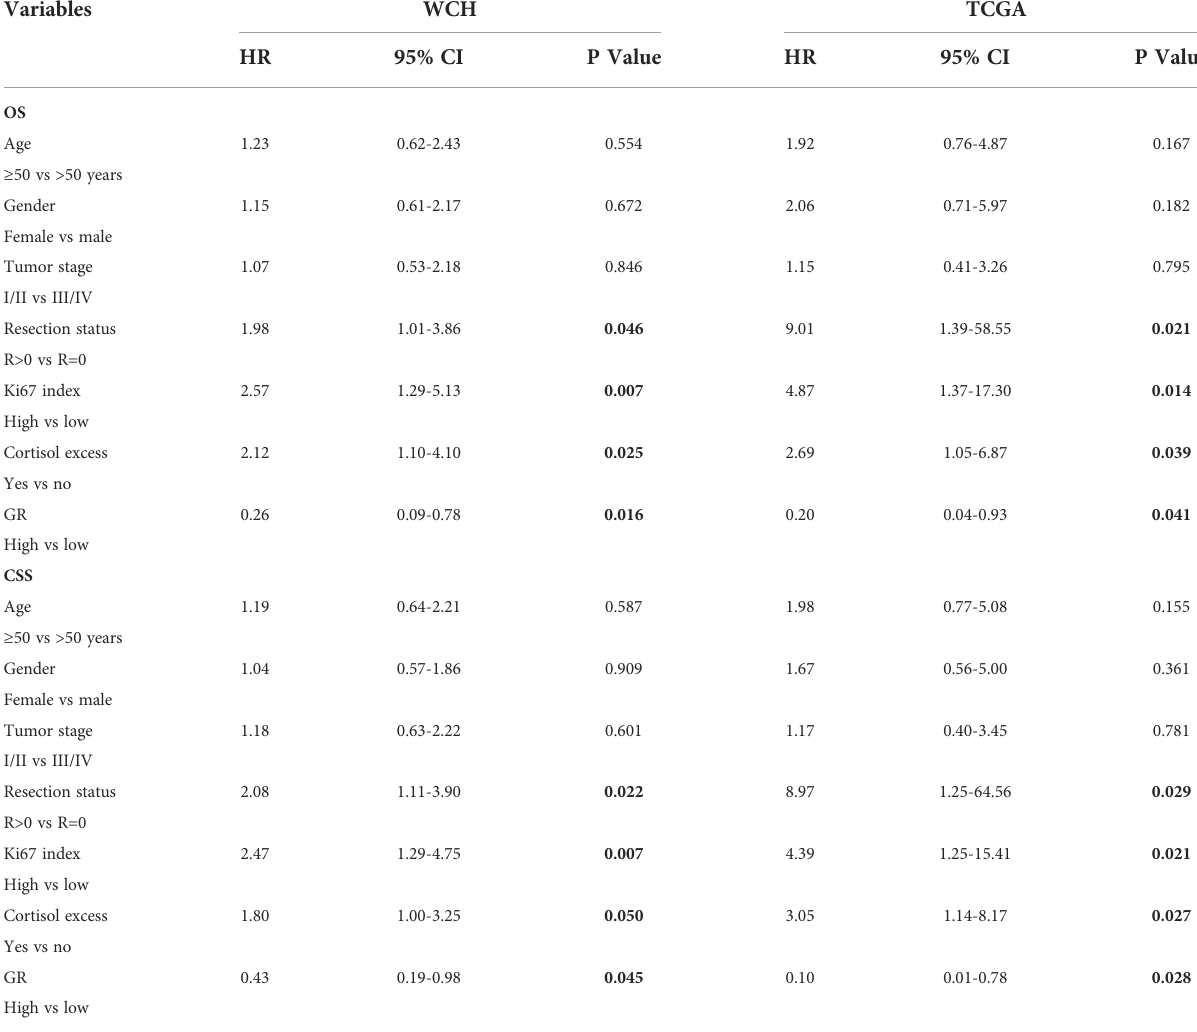
TABLE 2 Cox multivariate regression analyses of parameters associated with survival in WCH and TCGA cohort.